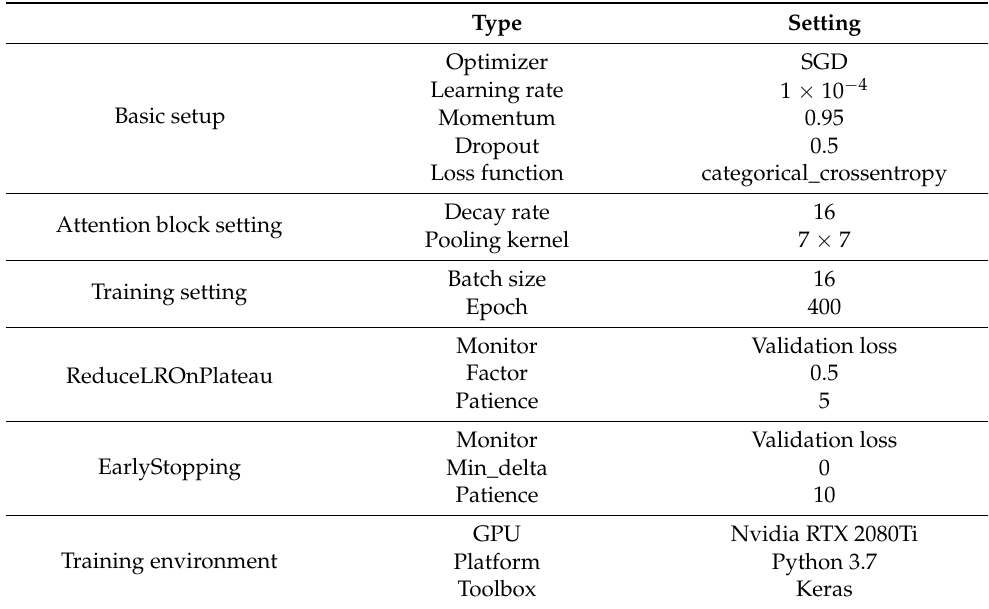
Table 3. Model-training hyperparameter